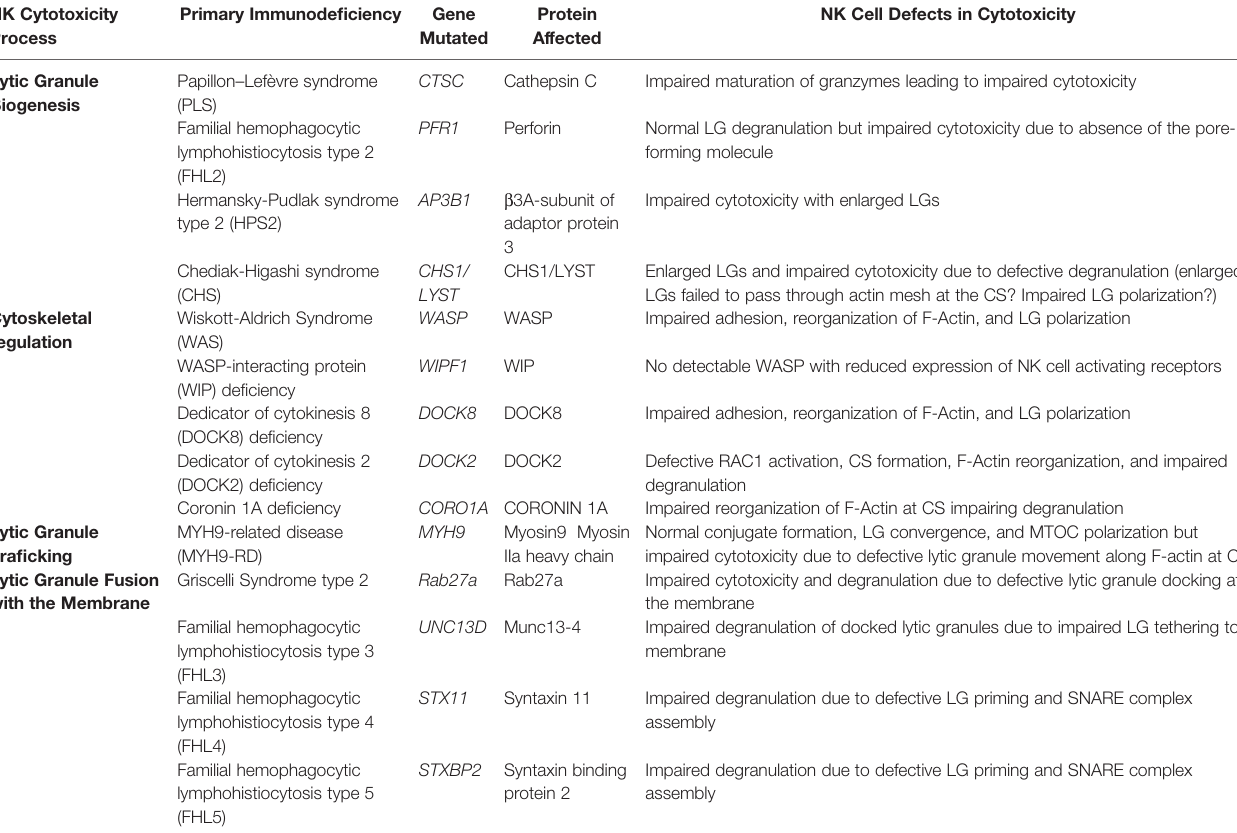
TABLE 1 | Human Primary Immunode fi ciency Syndromes Associated with Impaired Lytic Granule (LG) Degranulation by NK